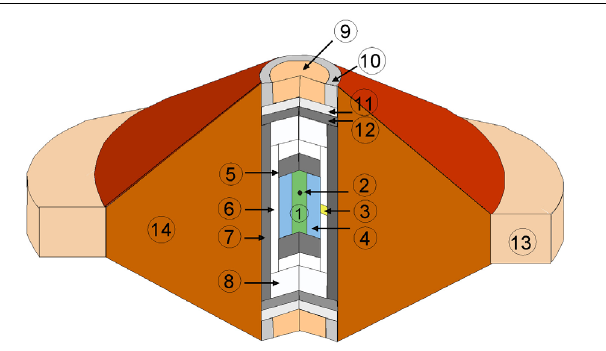
FIGURE 1 | Cell assembly used for in situ viscosity measurements. (1) sample, (2) rhenium sphere, (3) hBN + Pt calibrant, (4) single crystal diamond capsule, 1.5 mm length and 0.5 mm internal diameter, (5) graphite end-cap, (6) hBN capsule, (7) graphite heater, (8) hBN lid, (9) MgO powder, (10)